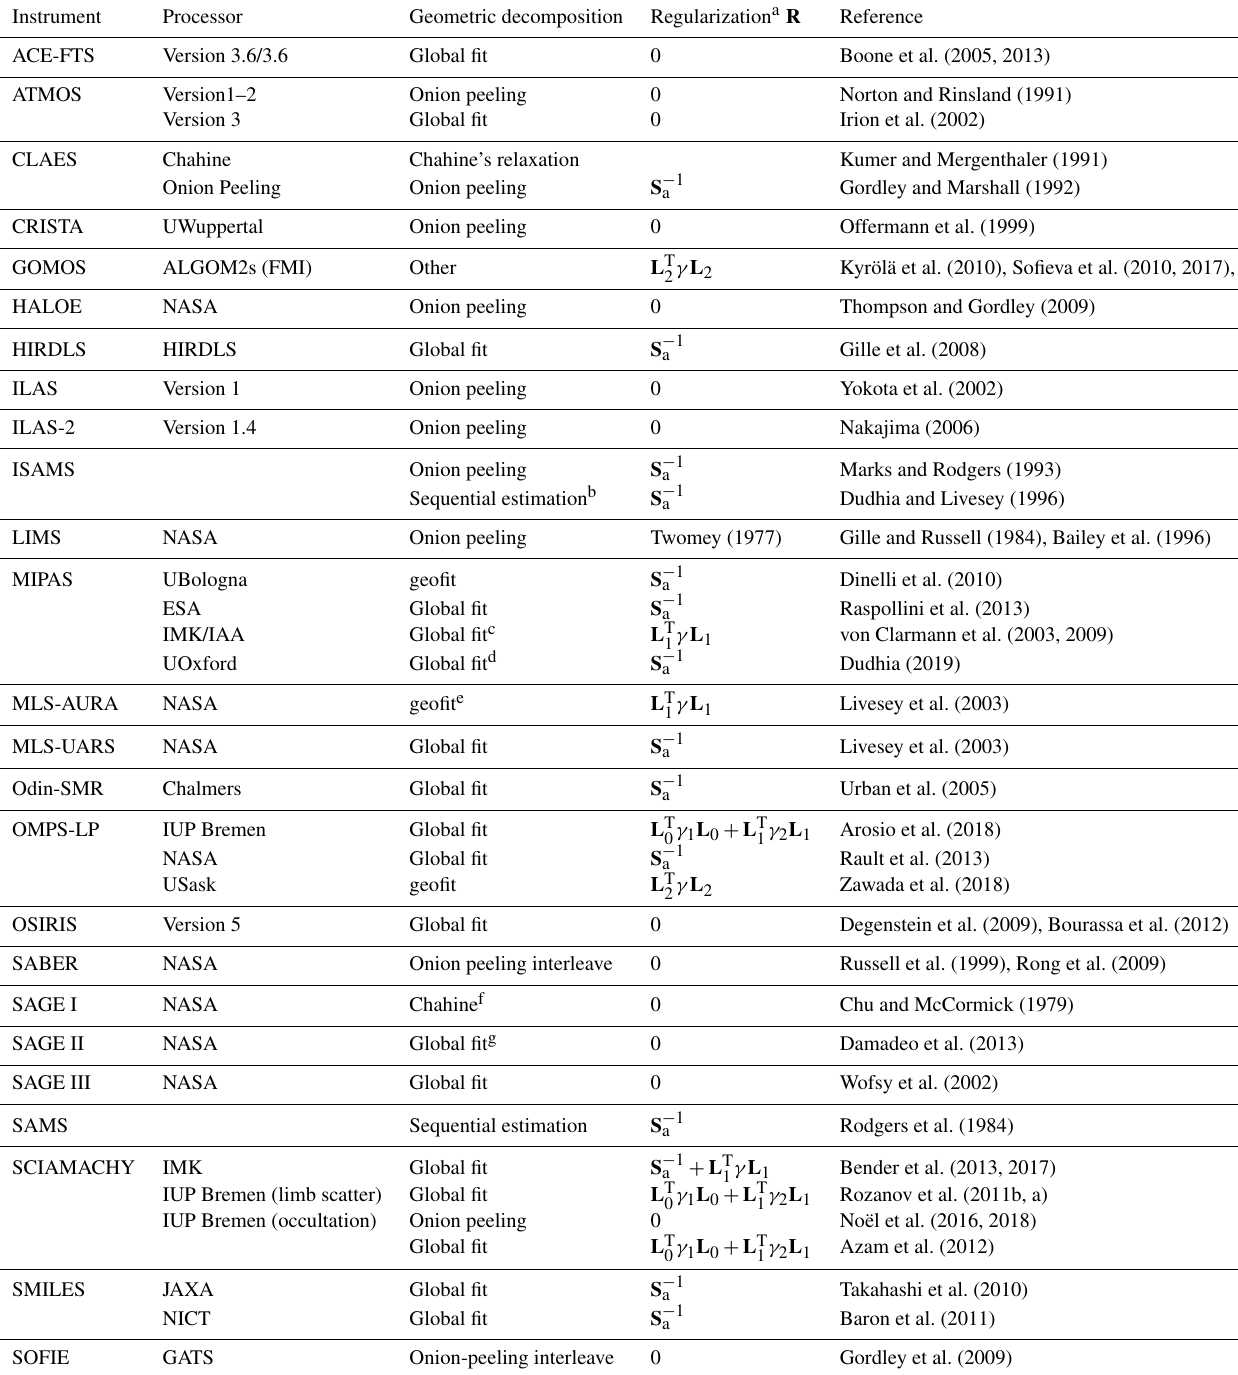
Table 1. Satellite data processors: limb geometry (emission, occultation, and